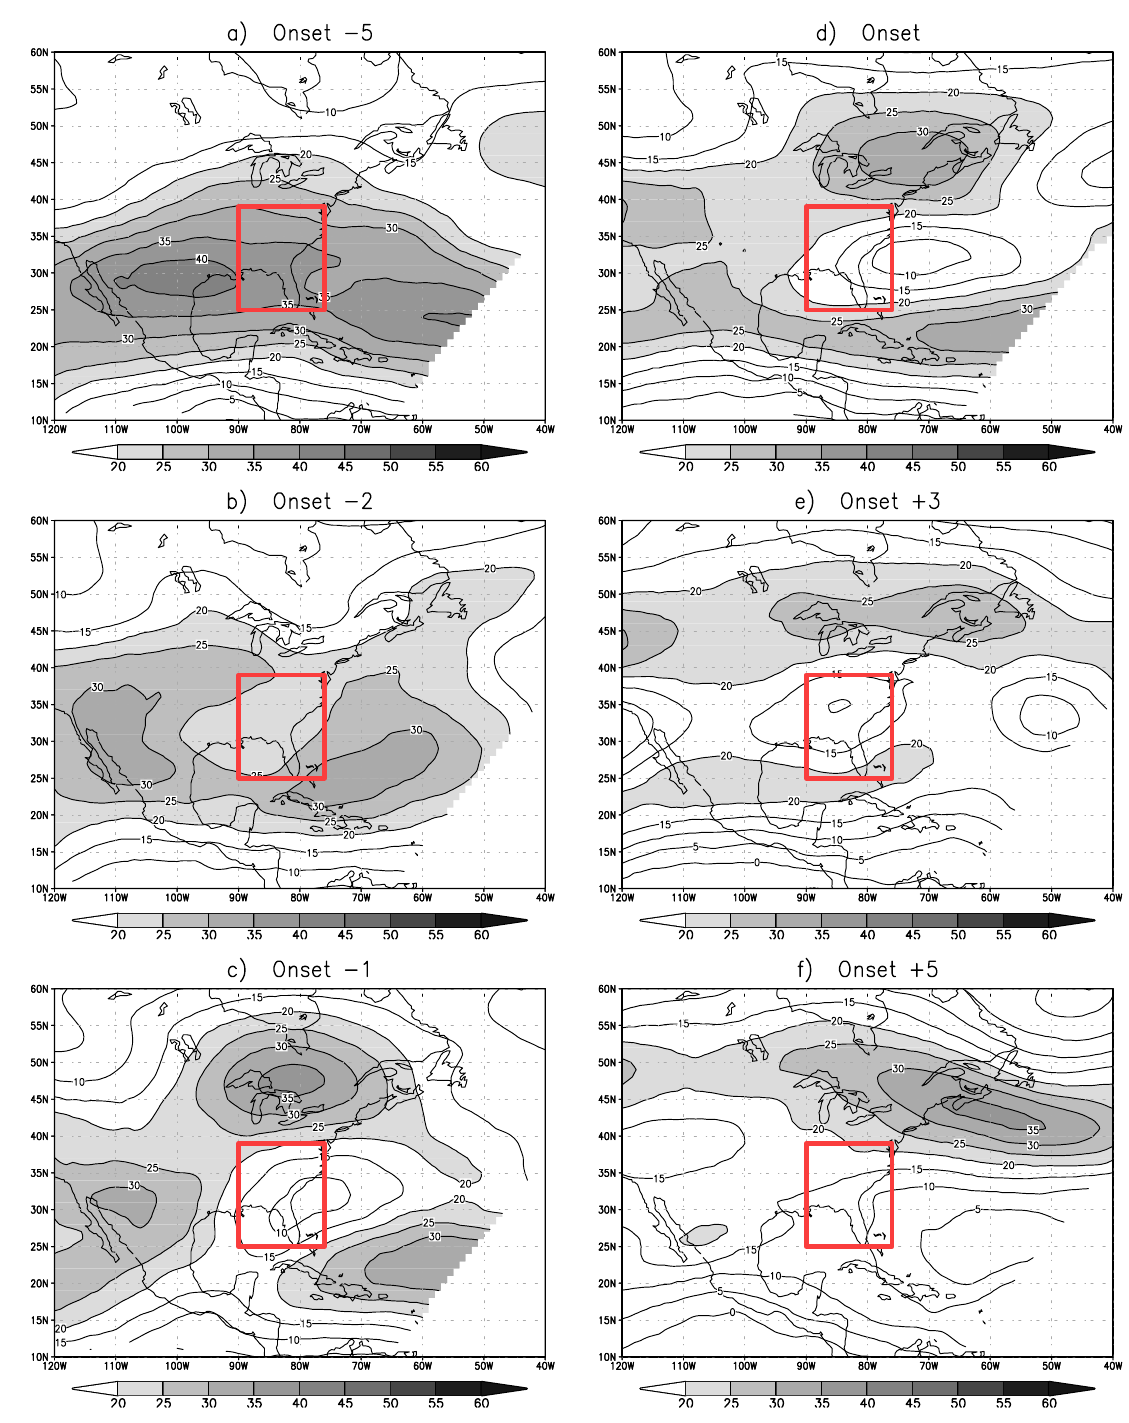
Figure 2. Pentad composites for the four-year period of zonal wind at 200 hPa (m s − 1 ) at the ( a ) onset − 5, ( b ) onset − 3, ( c ) onset − 1, ( d ) onset, ( e ) onset +3, and ( f ) onset +5 pentads. Red box marks the SE US domain.